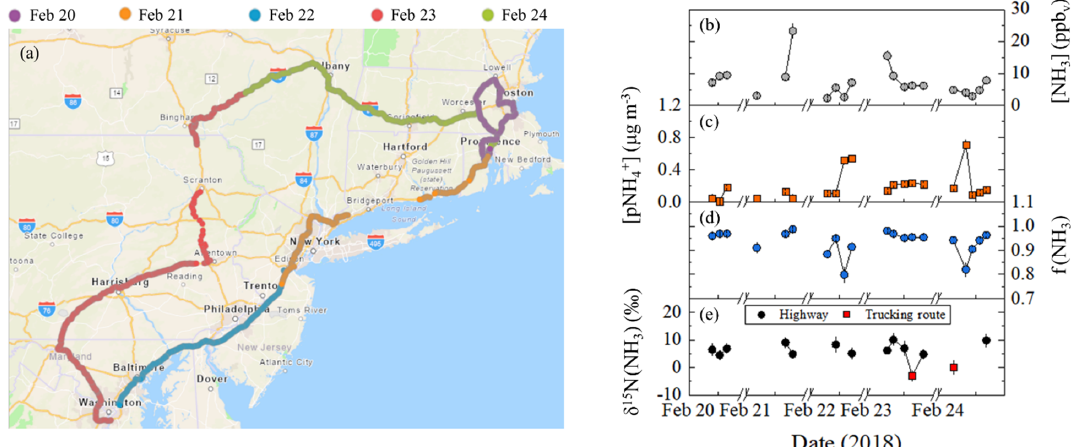
Figure 5. Mobile on-road (northeastern USA) measurements including (a) spatial mapping of measurement path sorted by date and data ] , (d) f ( NH =[ NH ] (mol)/ [ NH x ] (mol)), and (e) δ 15 N ( NH summary of (b) [ NH 3 ] , (c) [ pNH + 3 ) ( 3 3 ) for highway (black circle) and trucking 4 routes (red square). The NH x data were generated using a denuder-filter pack with a collection time of approximately 1h, and the error bars for concentrations and δ 15 N ( NH 3 ) measurements shown as black vertical lines represent the RSD (%) and propagated error, respectively. The breaks in the x axes separate breaks in the mobile measurements. Image (a) was created using ArcGIS Copyright © 1995–2019 Esri.